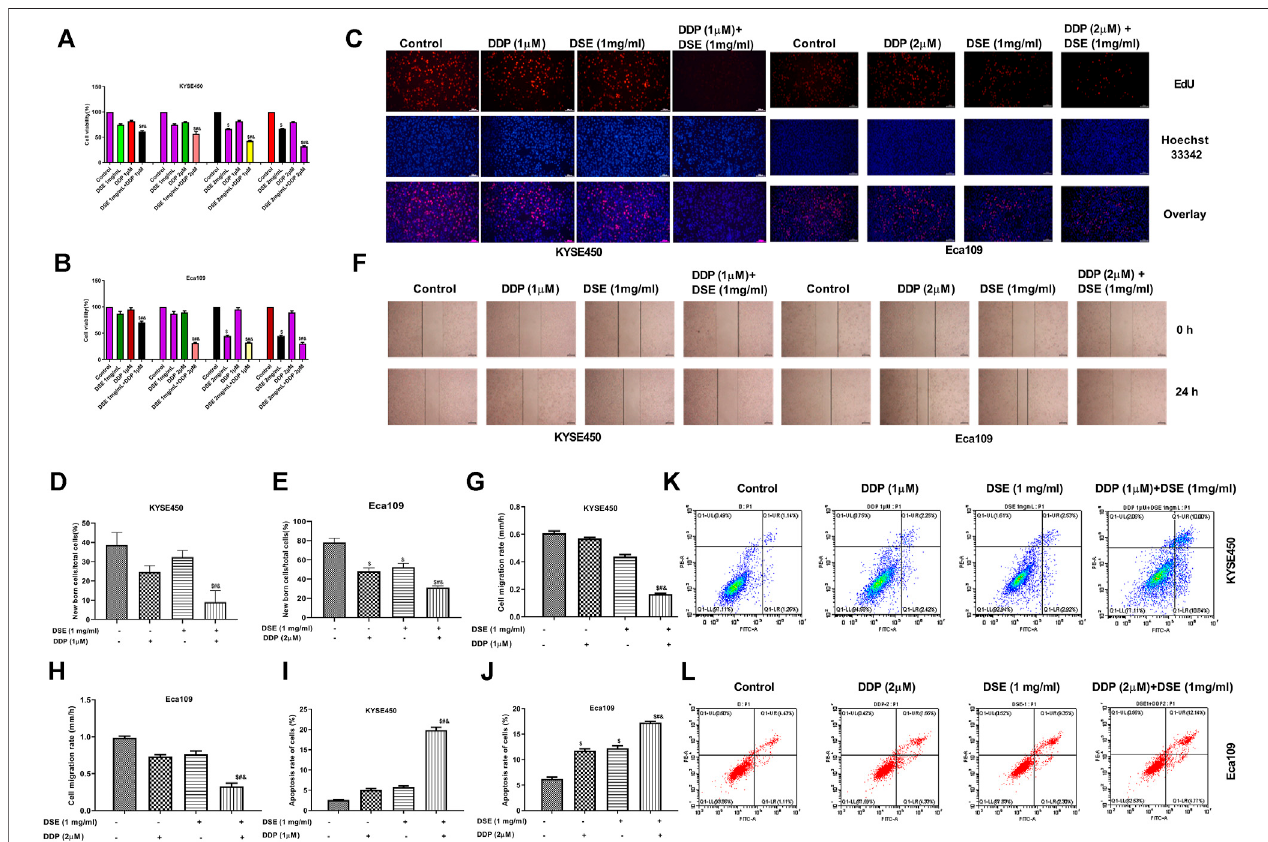
FIGURE8| DSEenhances thesensitivity ofDDP tohumanESCC cells. (A,B) EffectsofcombinationofDSEand DDP onthesurvivalrateofKYSE450and Eca109 cells. (C – E) Effects of combination of DSE and DDP on the proliferation of KYSE450 and Eca109 cells. Representative images were taken. Scale bars, 100 µm. (F – H) Effects of combination of DSE and DDP on the migration of KYSE450 and Eca109 cells. Representative images were taken. Scale bars, 500 µm. (I – L) Effects of combination of DSE and DDP on the apoptosis of KYSE450 and Eca109 cells. All data are expressed as mean ± standard deviation ( n = 3). $ p < 0.05 vs. control group. # p < 0.05 vs. DSE group. & p < 0.05 vs. DDP